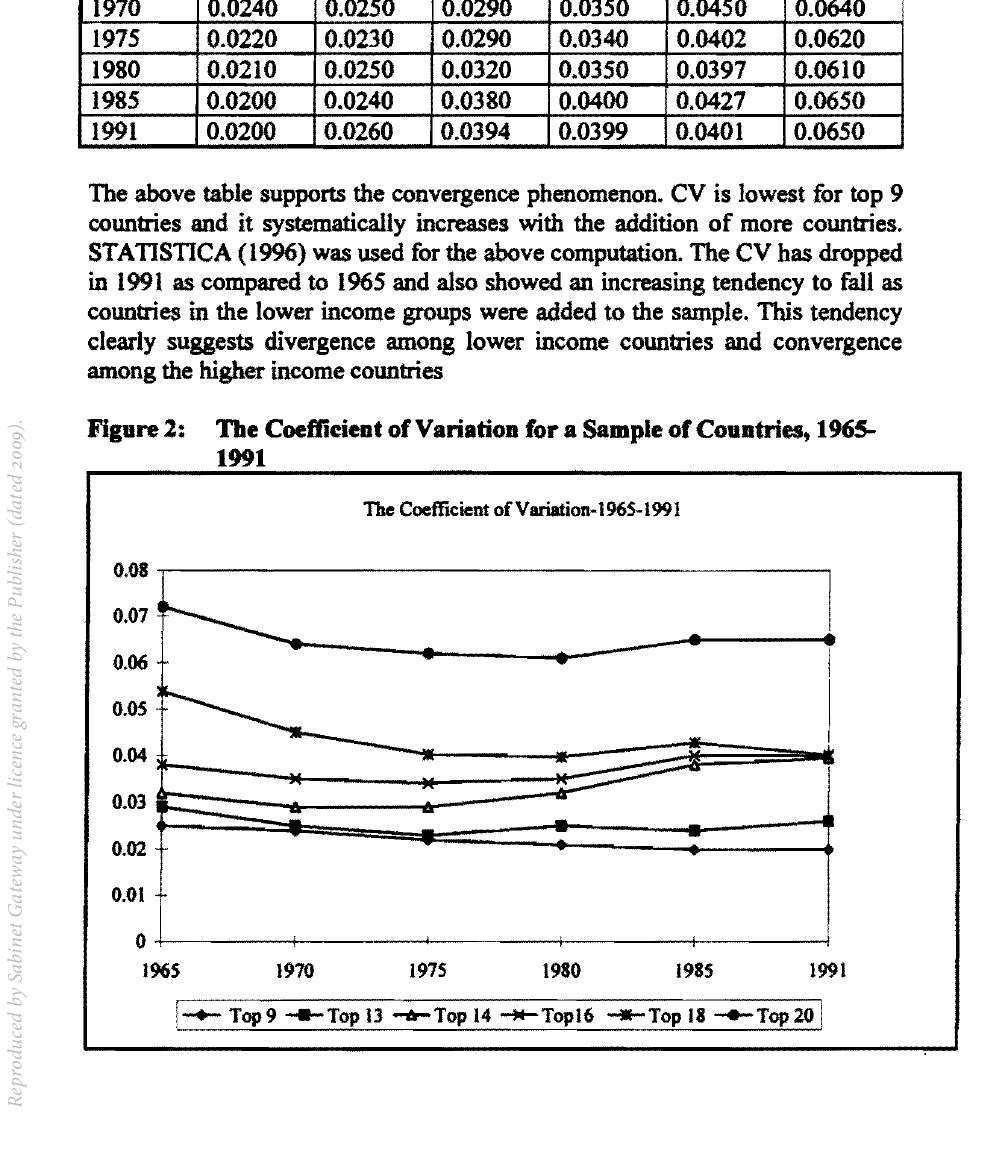
The Coefficient of Variation for a Sample of Countries,1965- 1991 .